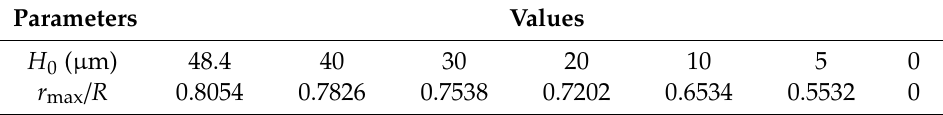
Figure 8. The amplitude distribution of the bionic structure for different thicknesses b .